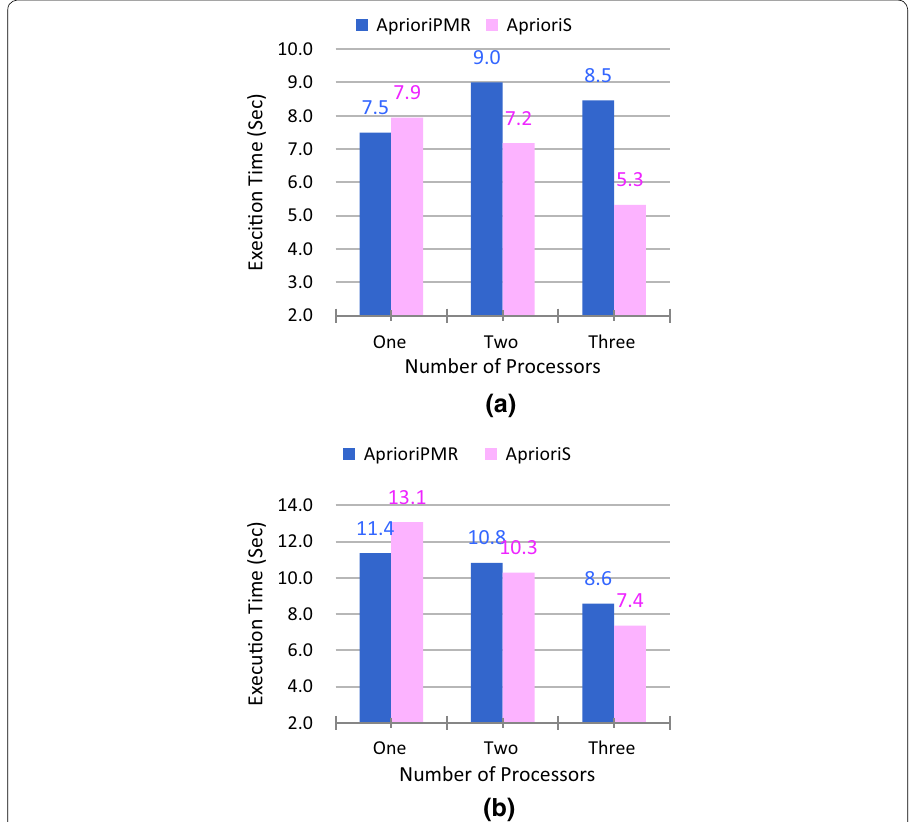
Fig. 9 Comparisons of execution times with multiple machines. Result of execution time comparison between AprioriPMR and proposed AprioriS on one, two and three machines environments. In part a , number of transactions is set to 50,000 while in part b number of transactions is set to